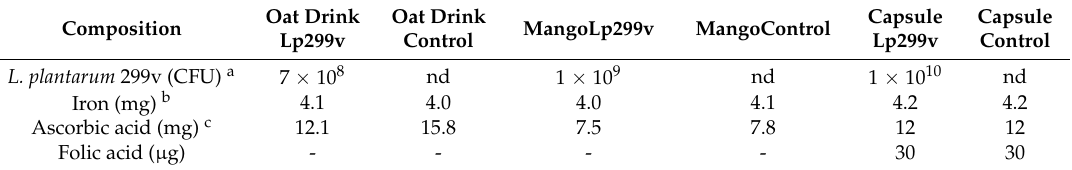
Table 1. Composition of the study products (per 200 mL drink and per